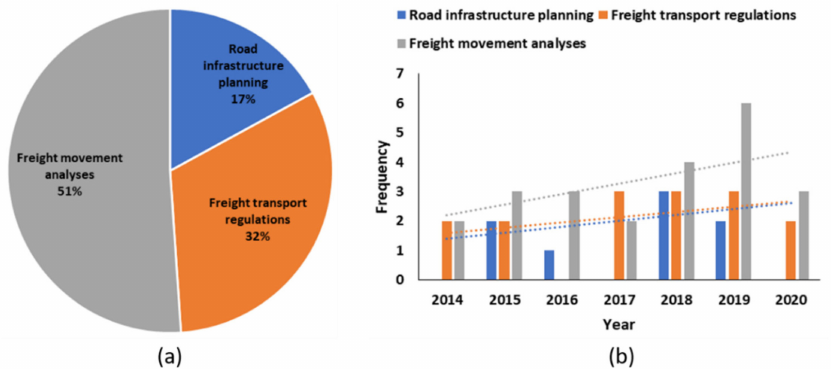
Figure 3. Distributions of the identified articles in relation to the three categories ( a ), and time analysis of the articles in each category ( b